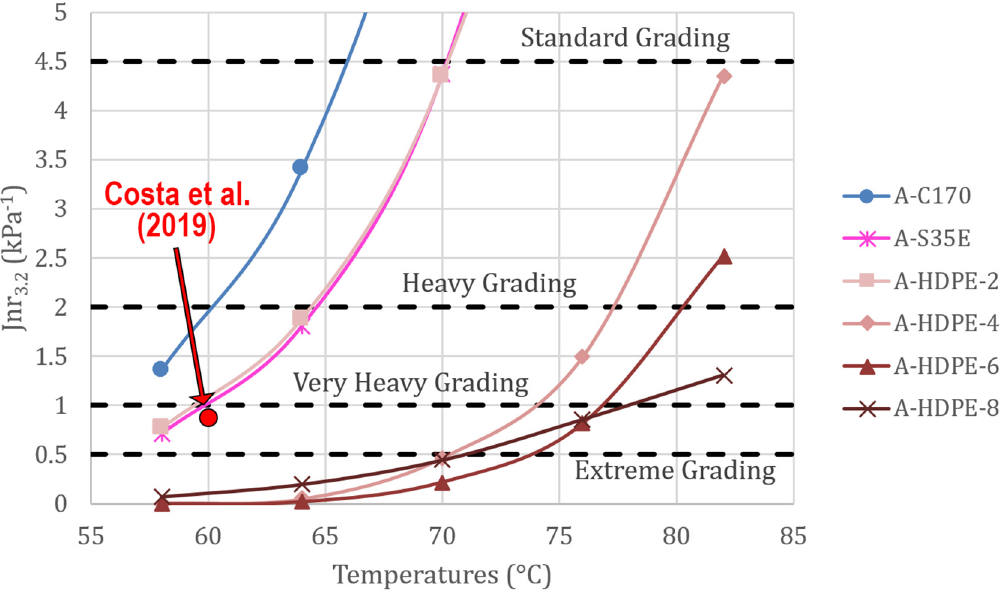
Figure 4. Results of aged non-recoverable compliance.